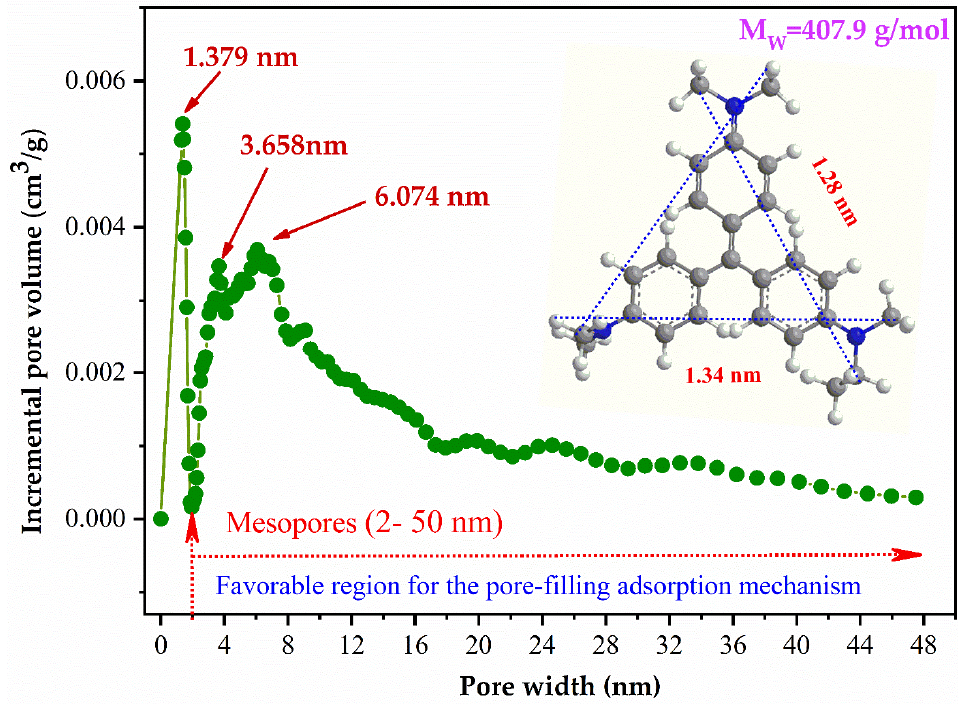
Figure 5. Pore size distribution of DSD sample and possibility of the pore filling diffusion of CV dye.